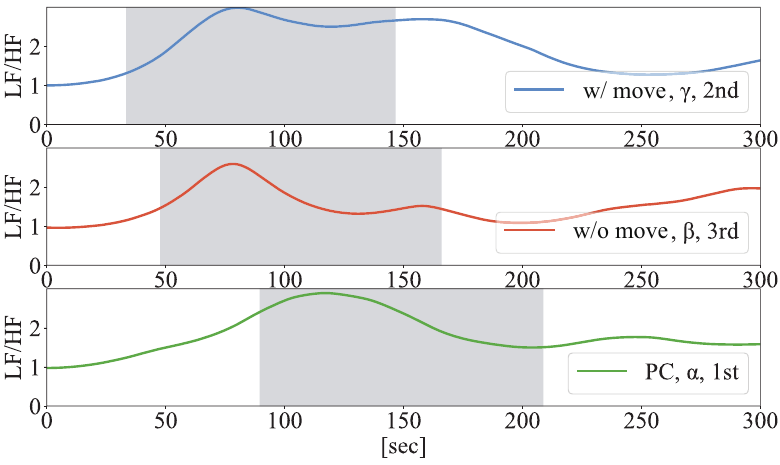
Figure 17. LF/HF data